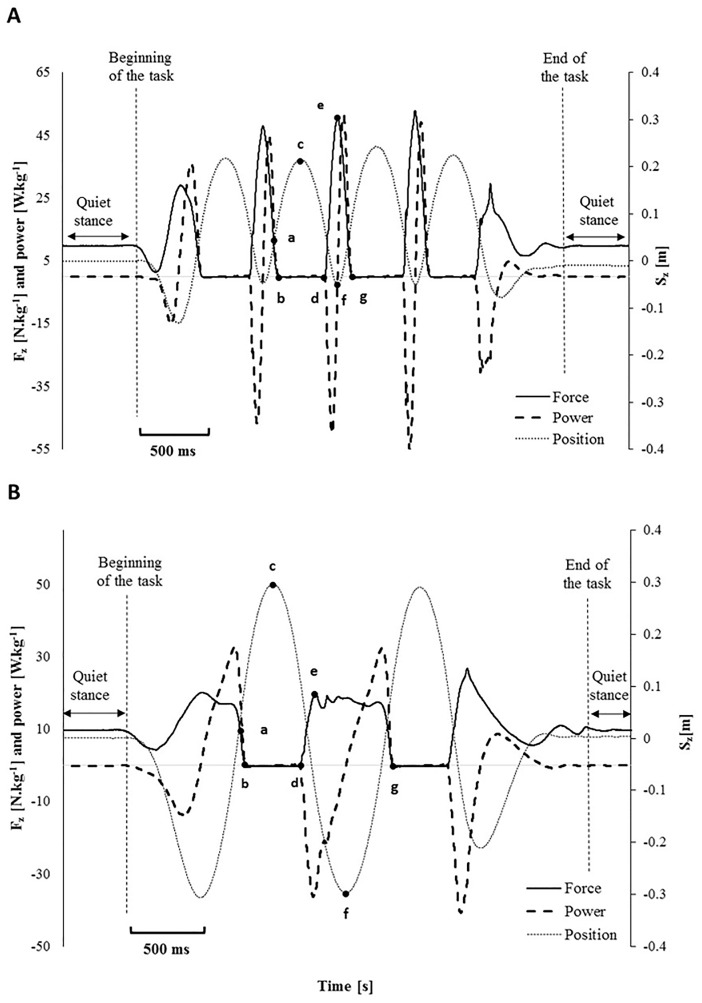
Example of Force (N.kg-1), Power (W.kg-1) and Position (m) curves for the ankle jumps (A) and multi-jump (B) tasks.a: ground reaction force is equal to body weight propulsion and jumper reaches maximum vertical velocity; b: take-off 1, when ground reaction force < 10 N; c: maximum jump height; d: touch-down; e: peak vertical ground reaction force; f: lower position of COM; g: take-off 2; b-d: Flight time; d-g: contact time.